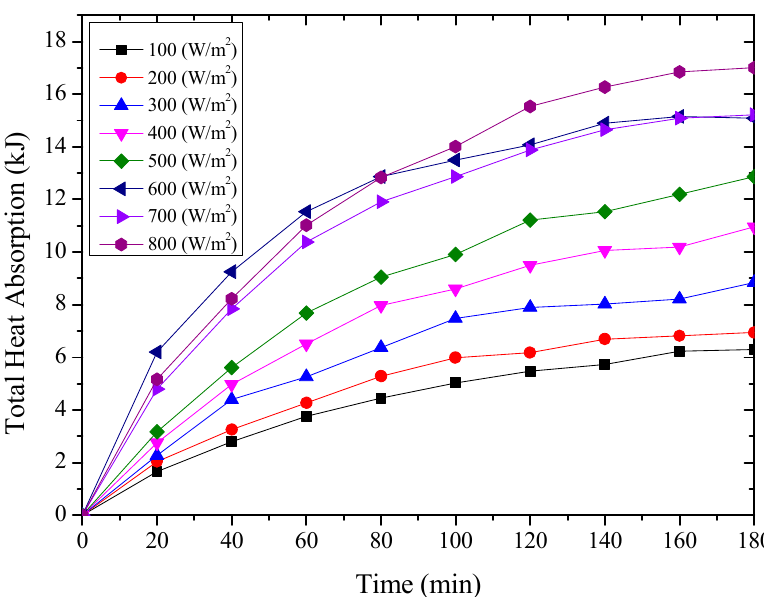
Figure 12. The amount of heat absorbed by the nanoporous alumina sheet with 30 nm pore diameter.